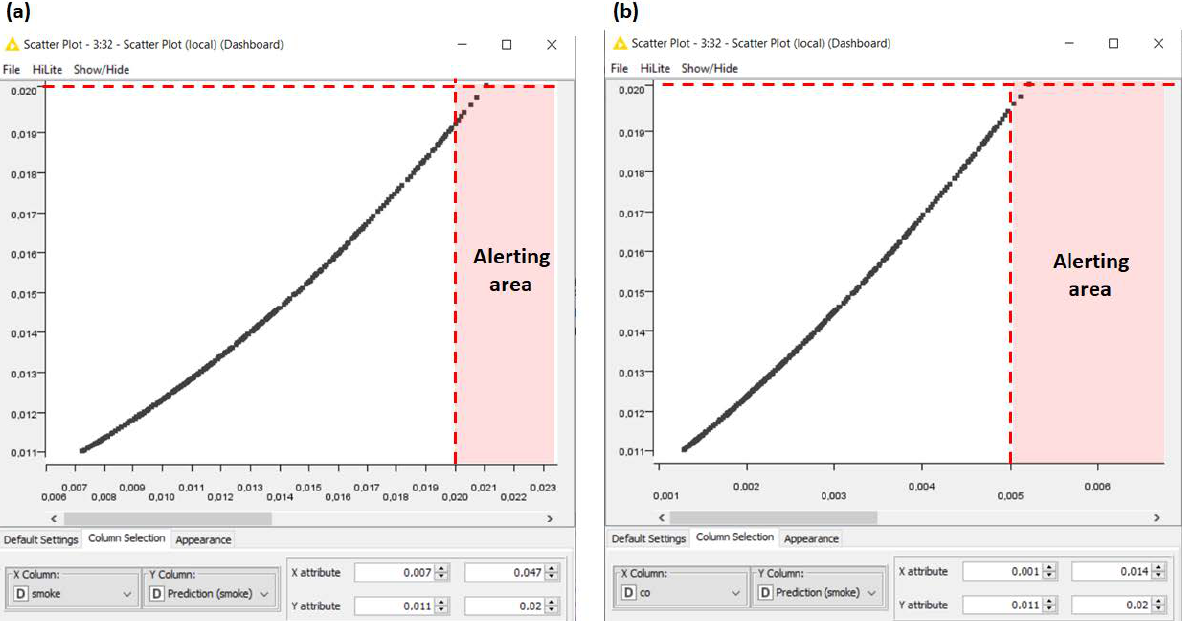
Figure 6. KNIME results: ( a ) correlation matrix of selected variables using a colored scale ( a ) and double precision values ( b ).